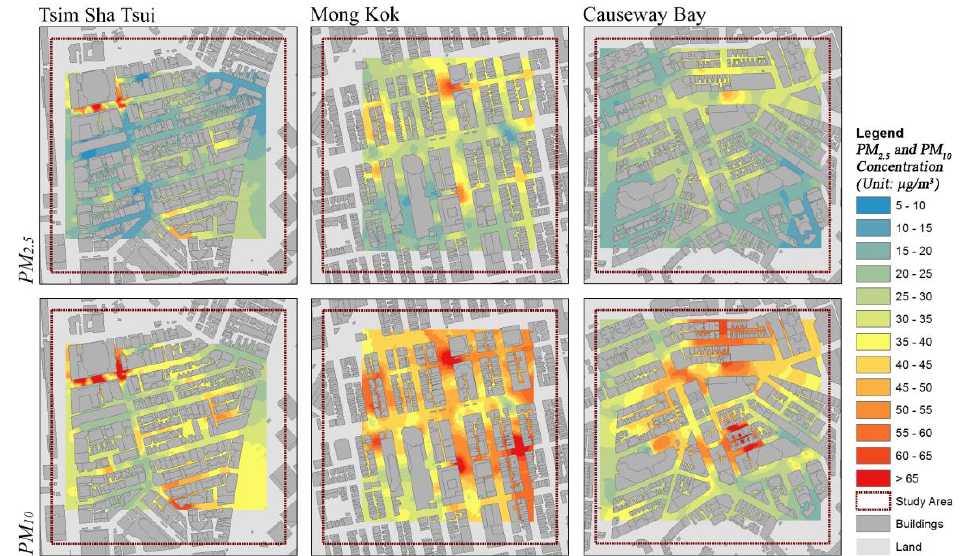
Figure 5. The resultant interpolation mapping of the PM 2.5 and PM 10 concentration in all three study areas.